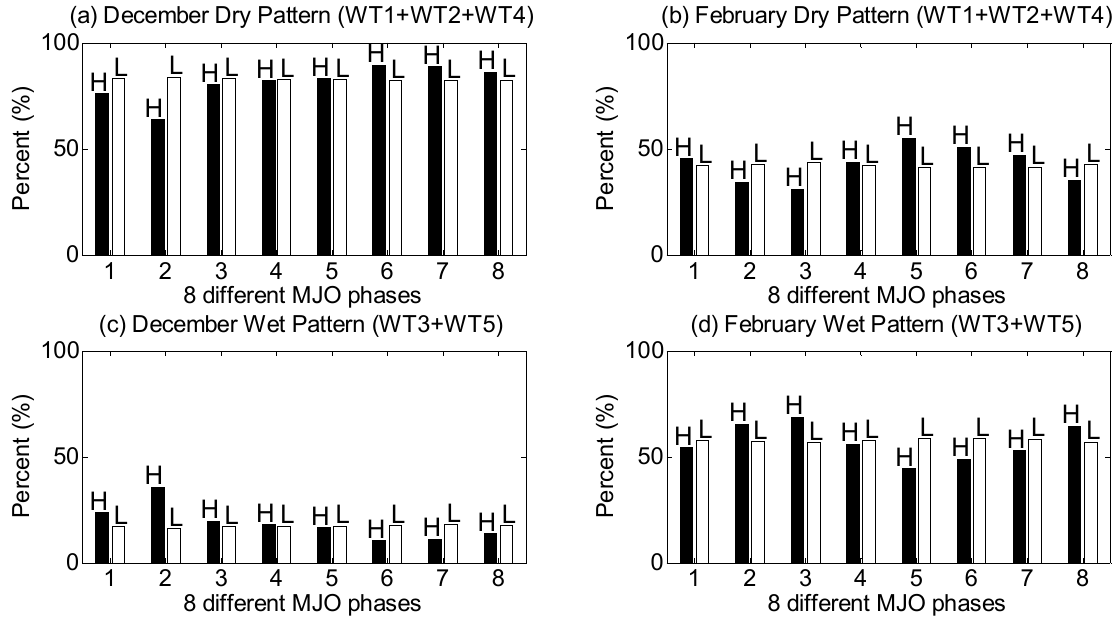
Figure 9. Intraseasonal variation of frequencies of di ff erent WTs (Dry and Wet). Frequencies for ( a ) December Dry Pattern (WT1 + WT2 + WT4), ( b ) February Dry Pattern (WT1 + WT2 + WT4), ( c ) December Wet Pattern (WT3 + WT5), and ( d ) February Wet Pattern (WT3 + WT5) during eight di ff erent phases of Madden–Julian Oscillation (MJO). For each MJO phase, the two bars represent the strong (denoted by H) MJO and weak (expressed as L) MJO,